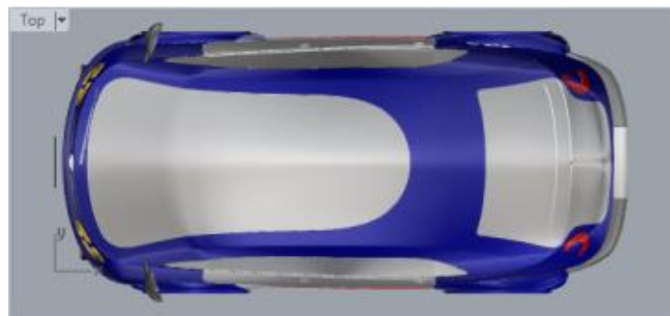
Figure 27. New FIAT 600 Omega—CAD 3D model: upper part of car body.